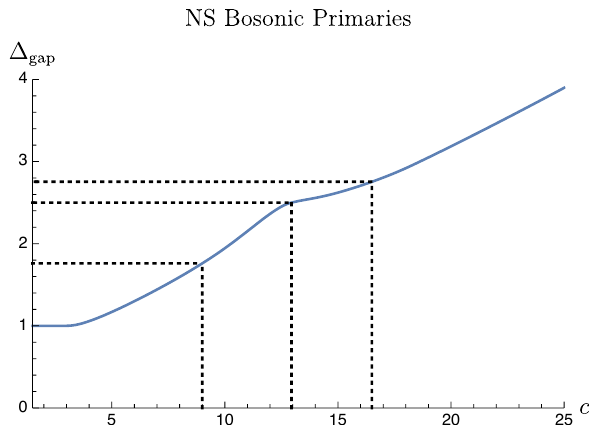
Figure 8: Upper bounds on the gap in the NS bosonic primary spec- trum, as the central charge is varied up to c = 25. The dashed lines mark the bounds at c = 9,13, 33 . 2